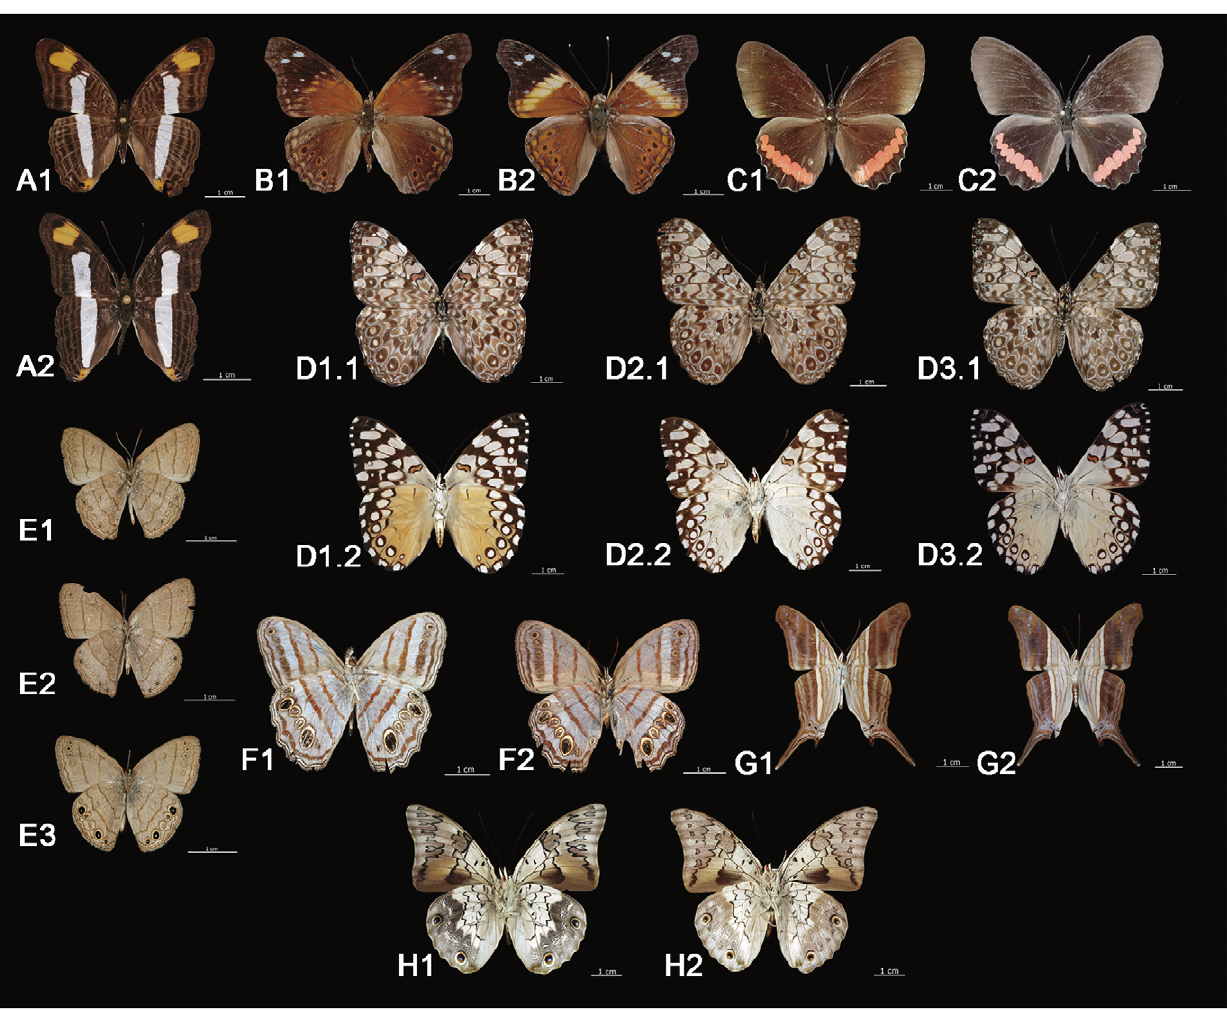
Figure 3. Species of Nymphalidae from the Yucatan Peninsula showing deep sequence divergence ( . 2%) at COI. Sequences in 7 species were partitioned into two clusters, while one species included three clusters. A1) Adelpha basiloidesECO01, A2) A. basiloidesECO02; B1) Asterocampa idyjaECO01, B2) A. idyjaECO02; C1) Biblis hyperiaECO01, C2) B. hyperiaECO02; D1) Hamadryas feroniaECO01, D2) and D3) H. feroniaECO02, images D1.1, D2.1 and D3.1 showing dorsal view; E1) Hermeuptychia hermesECO01, E2) H. hermesECO02, E3) H. hermesECO03; F1) Magneuptychia libyeECO01, F2) M. libyeECO02; G1) Marpesia chironECO01, G2) M. chironECO02; H1) Prepona laertesECO1 and H2) P. laertesECO02. Images A, B, C and E are dorsal views while F, G and H are ventral views. Photos by Humberto Bahena.